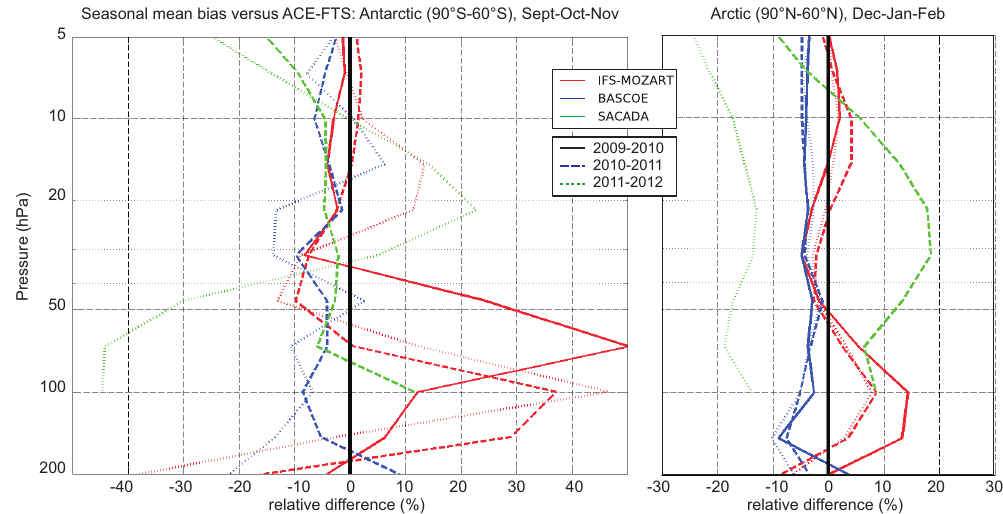
Figure 7. Seasonally averaged relative ozone bias profiles of IFS-MOZART (red), BASCOE (blue), and SACADA (green) vs. ACE-FTS (analysis minus observations) in % for the Antarctic spring (left: months September, October, and November) and for the Arctic winter (right: months December, January, and February) in 2009–2010 (full lines), 2010–2011 (dashed lines) and 2011–2012 (dotted